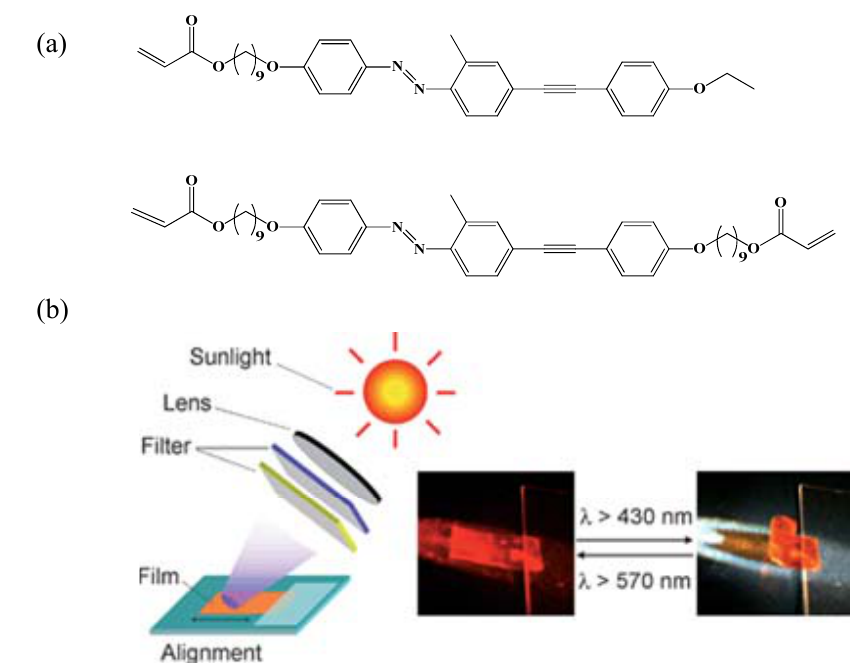
Figure 16. ( a ) Chemical structure of LC monomer and crosslinker used to synthesize an azotolane LCN film, ( b ) photo-induced bending and unbending behavior of the CLCP films on exposure to sunlight through a lens and glass filters to let desired wavelength of light pass through. Over irradiation with >430 nm sunlight the film bends towards the light and on exposing the CLCP films to >570 nm light results in unbending of the films to initial flat position. Reproduced from [80] with permission of The Royal Society of